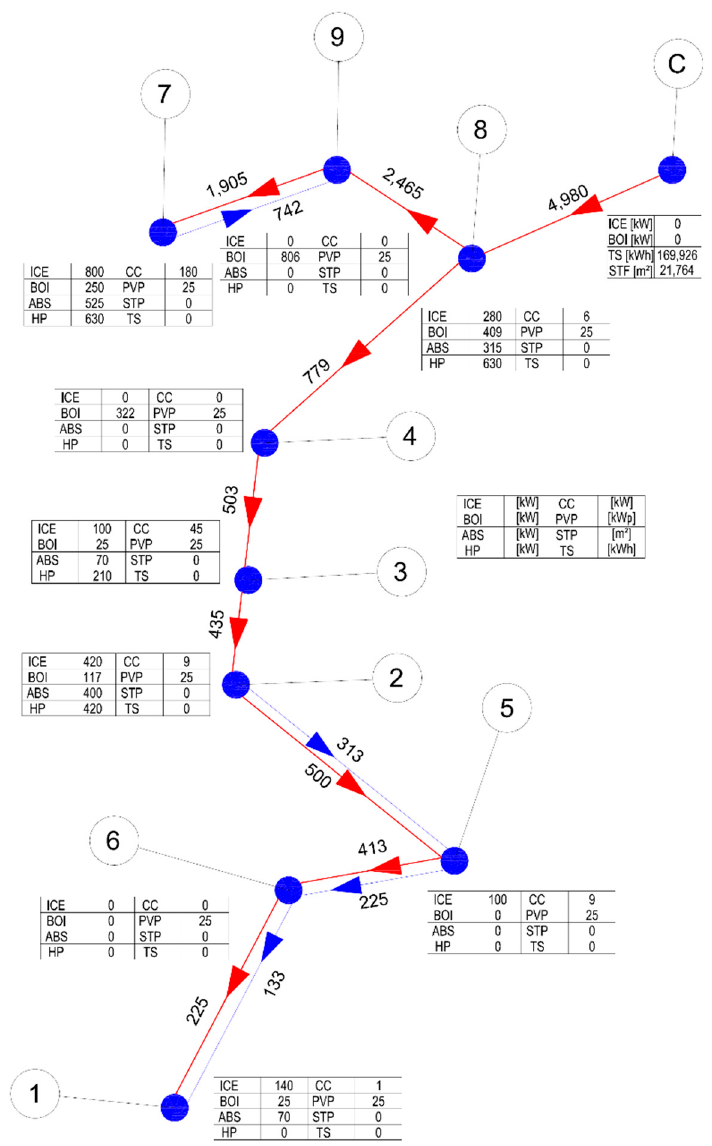
Figure 16. Optimal DHCN of the 70% environmental optimum—complete distributed generation solution. In red the DHN pipes and in blue the DCN pipes have been reported together with their size (kW). The tables report the size of the components installed.